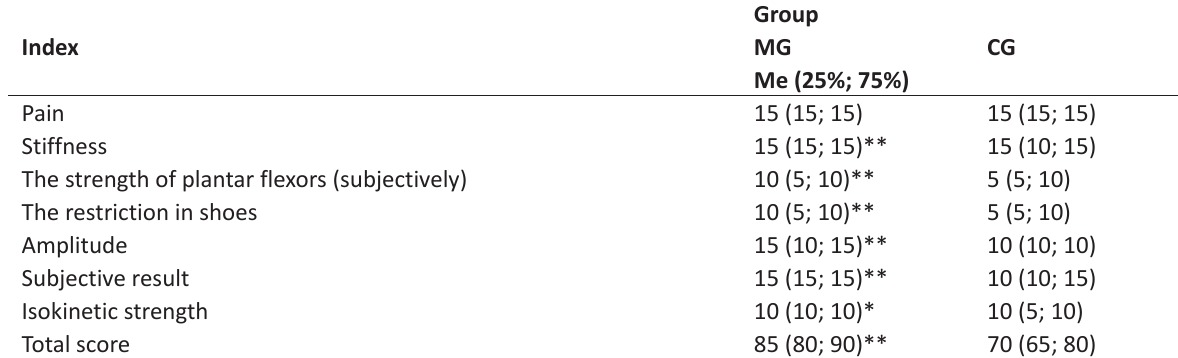
Table 3. Statistical measures by the Scale of assessment (by Leppilahti at al. [17]) after rehabilitation,